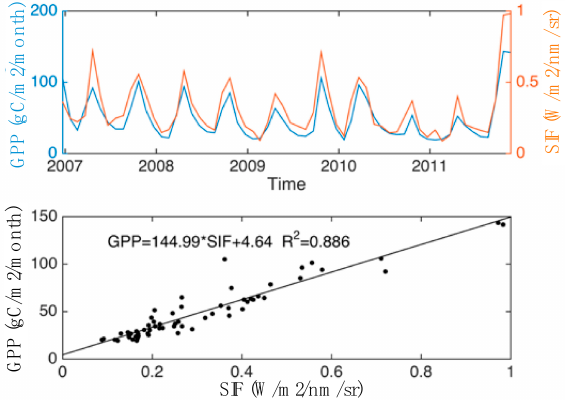
Figure 3. The relationship between solar-induced chlorophyll fluorescence (SIF) and gross primary production (GPP): ( top ) spatiotemporally-averaged SIF and GPP for the black box region in Figure 1; ( bottom ) the relationship between SIF and GPP.